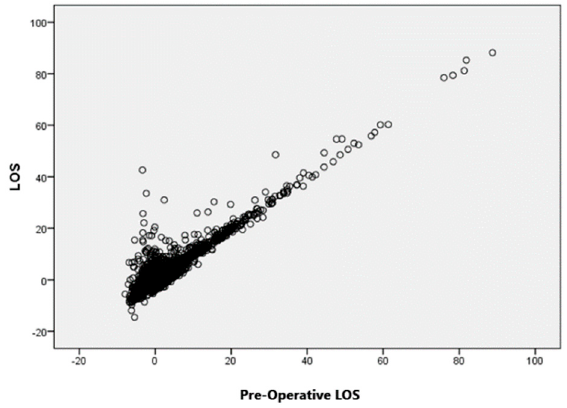
Figure 3. Partial regression plot of the multiple linear regression model.